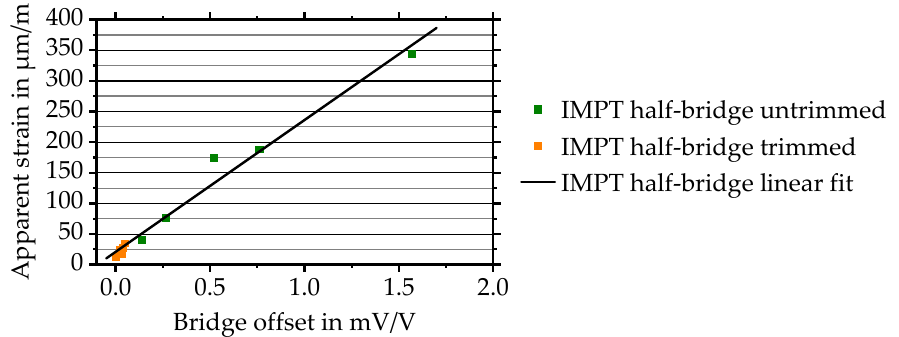
Figure 9. Apparent strain of trimmed and untrimmed half-bridges. Fit is generated from all shown half-bridge values.